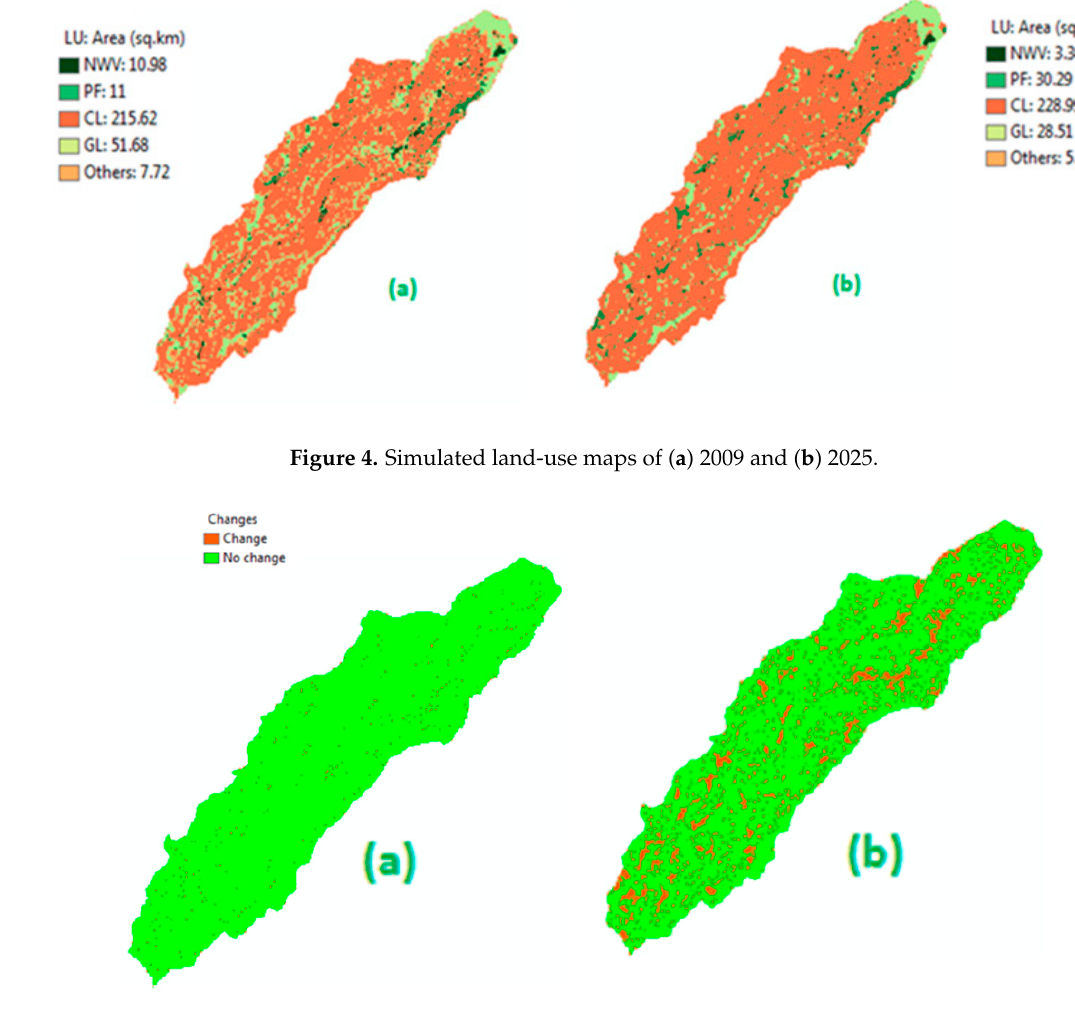
Table 8. Land-use conversion matrix (2009–2025): total area of conversion between land-cover types in km 2 and percentages (in brackets).